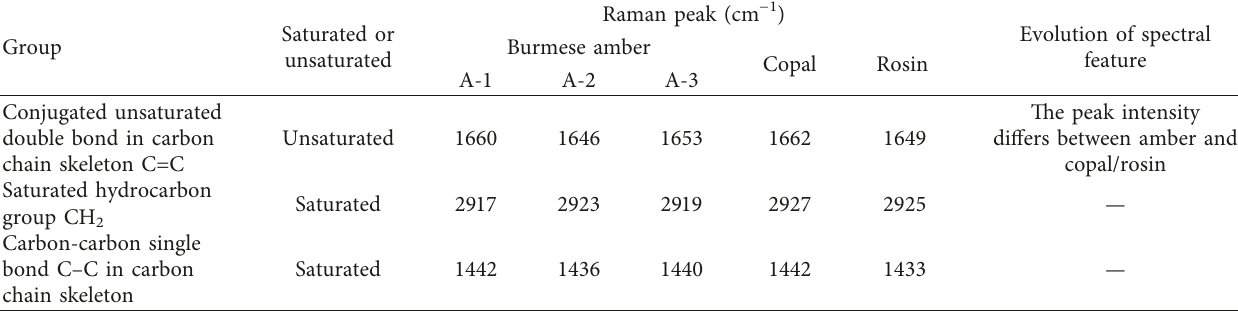
Table 2: Raman peak attributions of the amber, copal, and rosin